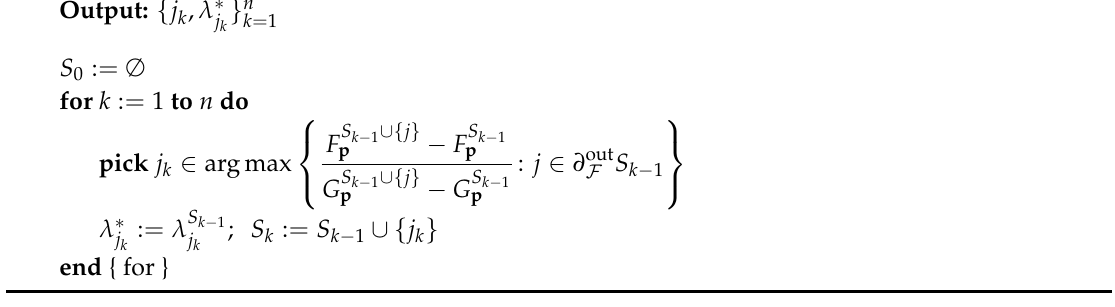
Algorithm 4: Reformulated adaptive-greedy index algorithm: bottom-up version AG BU F